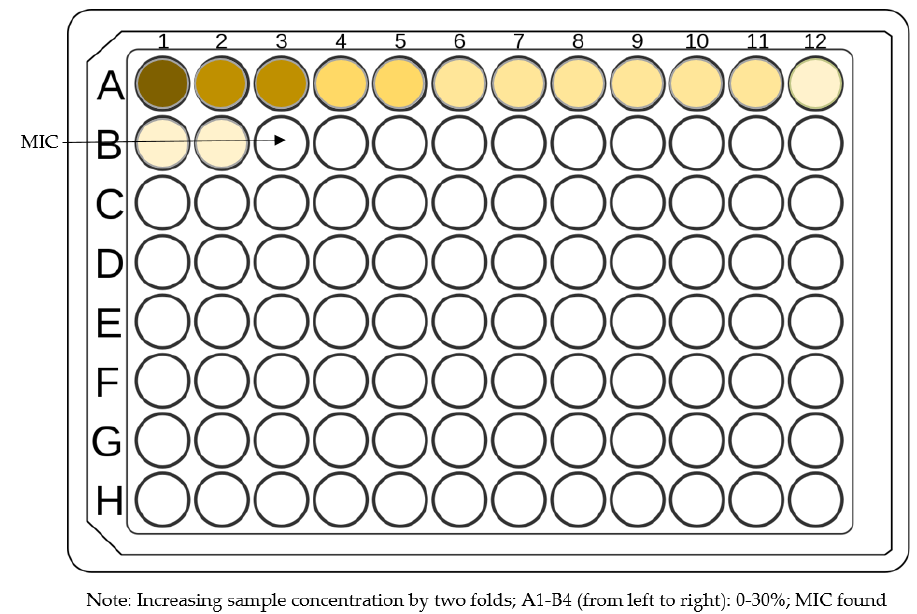
Figure 6. Schematic representation of broth dilution method.